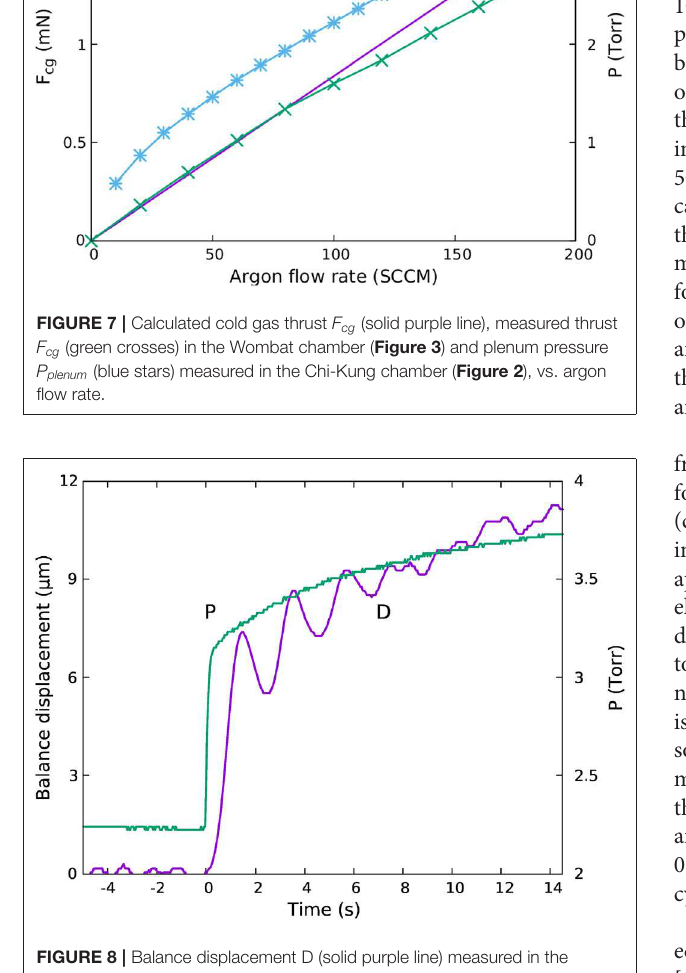
FIGURE 8 | Balance displacement D (solid purple line) measured in the Wombat chamber and plenum pressure P plenum (solid green line) measured in the Chi-Kung chamber, over time for 100 SCCM of argon and 50 W of RF. The RF is switched on at t = 0 s. The RF current flowing on the antenna when the RF is switched on is ∼ 4 A